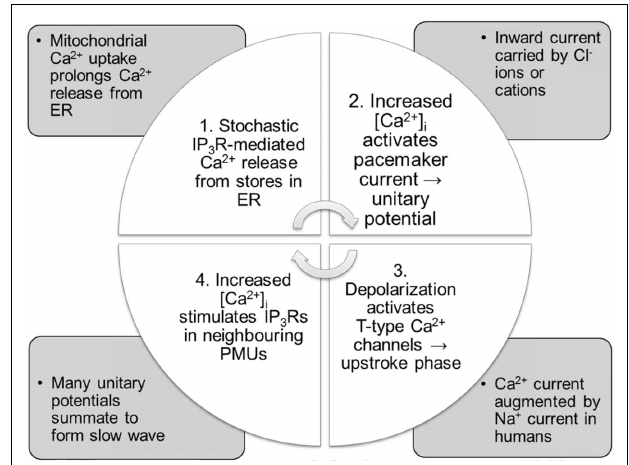
FIGURE 3 | Summary of the updated pacemaker cycle. The mechanisms involved are described in more detail in the